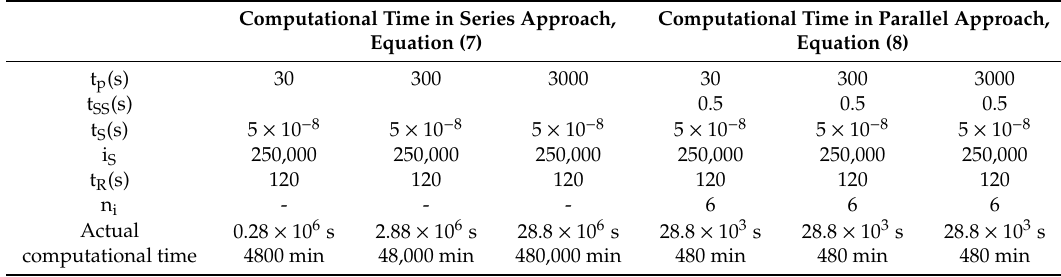
Table 5. E ff ect of time required to generate 0.3 mm flank wear and computational time with series and parallel